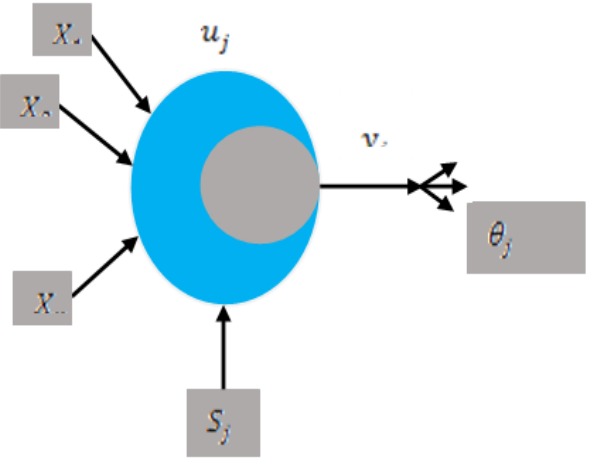
Figure 3: Artificial neuron